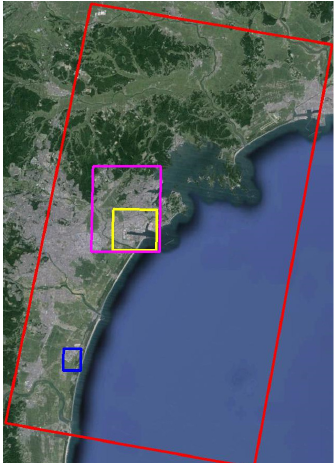
Figure 1. Study area in Sendai area, Japan. The vertical axis coincides with north-south direction. The red square indicates the border of TSX image acquired on March 12, 2011 (one day after the tsunami). The Sendai harbor (yellow square) is chosen as the cutout of false-color image in section 2.2. With respect to linear-feature change detection using Curvelet-based approach, the pink square indicates the composite study area in section 4.3, and the blue square encircles an area of interest in section 4.4. Three approaches of change detection based on SAR techniques using spaceborne data are presented in this paper. In case of disaster, rapid extraction of useful information from accessible data is needed for rescue operation and decision making. In (1) two TSX amplitude images are used as red, green and blue bands of a false-color image. The allocation way depends on the anticipated presentation of visual pattern in change. Discrepancies in scattering coefficients of corresponding pixels between these two TSX images cause color variations